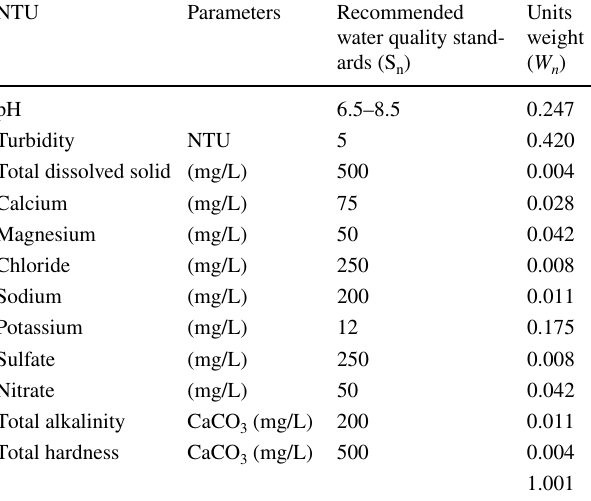
Table 4 Recommended Standards for drinking water quality and unit weight of individual parameters